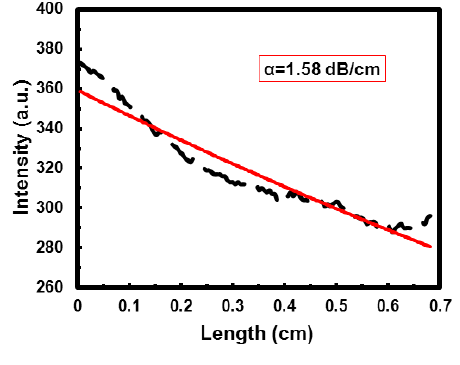
Figure 7. Optical attenuation of the fundamental TE mode in undoped 7-layer ZnO thin film: surface scattering measurement (dotted line), with exponential fit (in